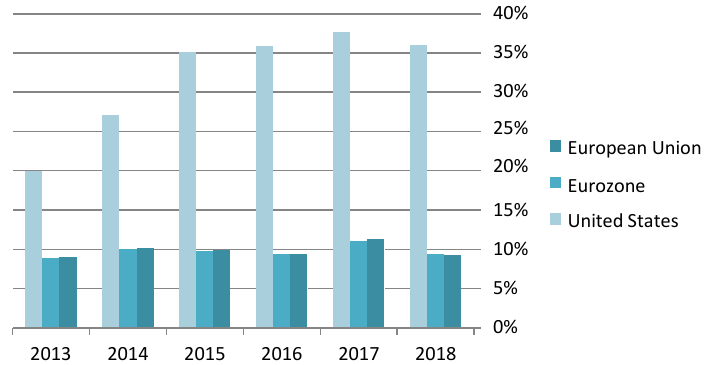
Figure 2. Median